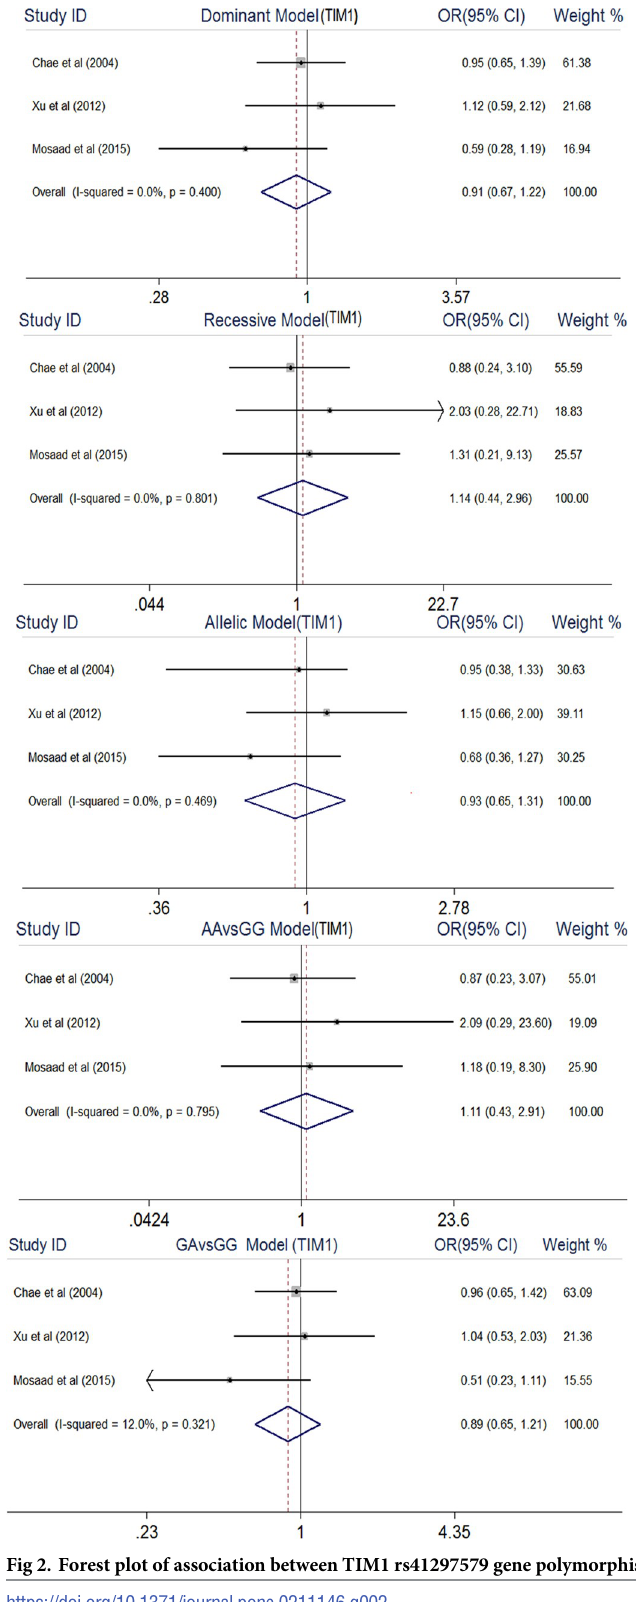
Fig 2. Forest plot of association between TIM1 rs41297579 gene polymorphism and rheumatoid arthritis.